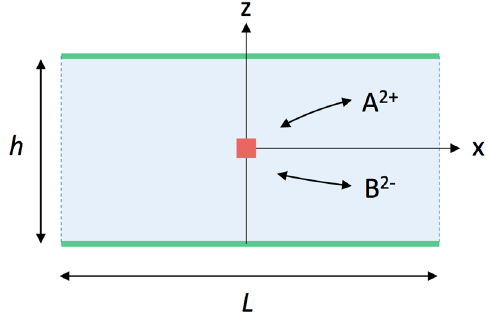
Figure 3. Schematic of the setup used for the finite element simulation.